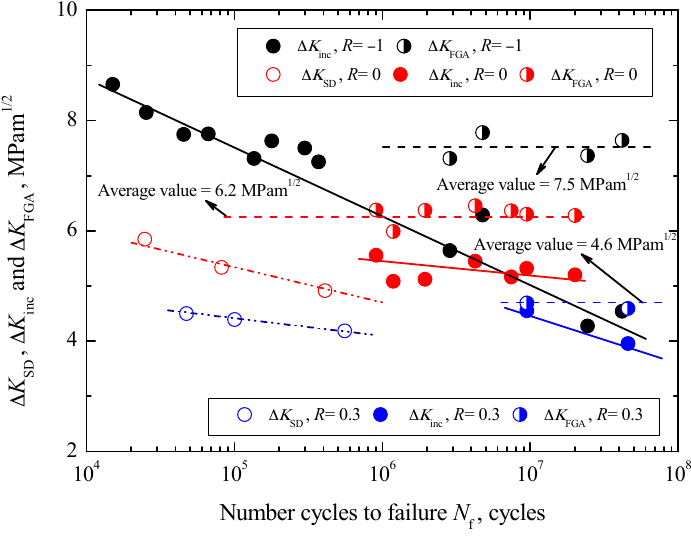
Figure 10. Relationships between Δ K SD , Δ K inc and Δ K FGA , and N f .